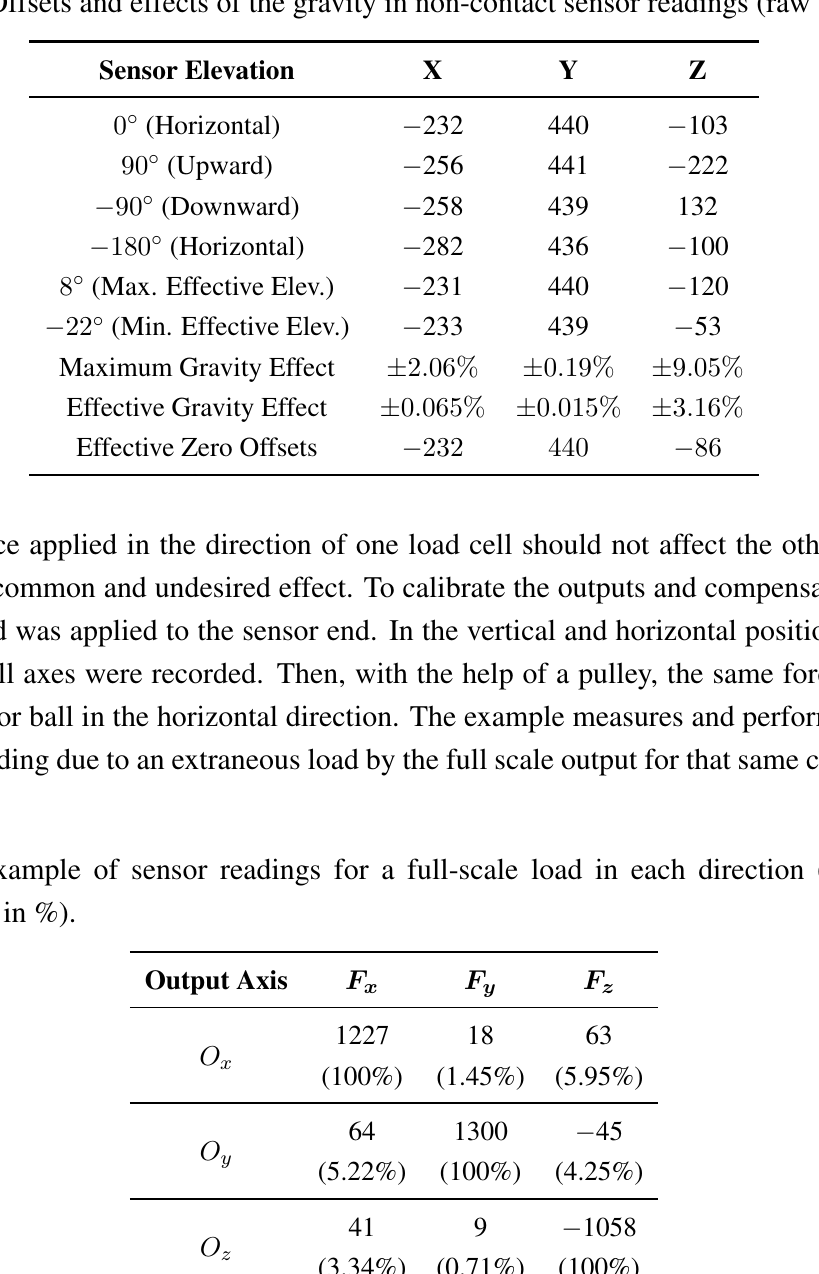
Table 1. Offsets and effects of the gravity in non-contact sensor readings (raw values).